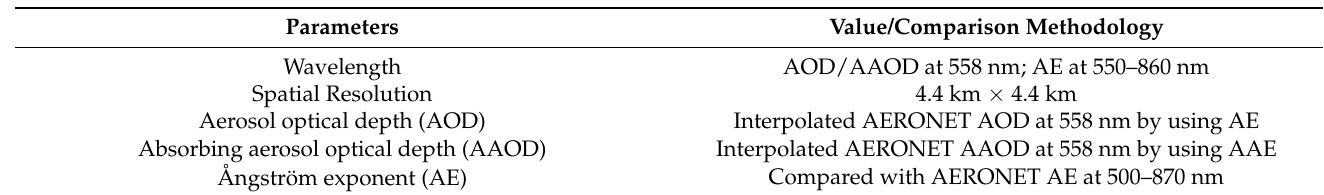
Table 1. The detailed information and comparison methodology of MISR V23 aerosol products used in this paper.